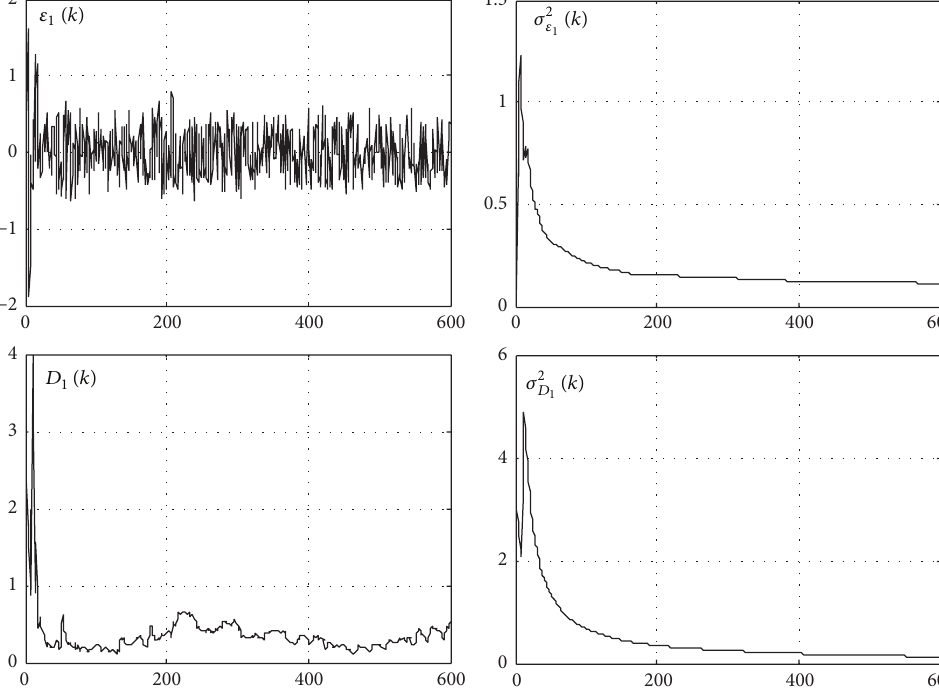
Figure 4: Evolution curves of the prediction error 𝜀 1 (𝑘) , the parametric distance 𝐷 1 (𝑘) , and their overall variances 𝜎 2 𝜀